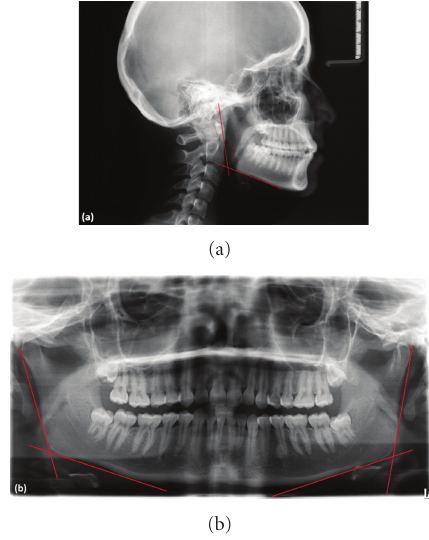
Figure 1: Measurement of the gonial angle in LCR (a) and PR